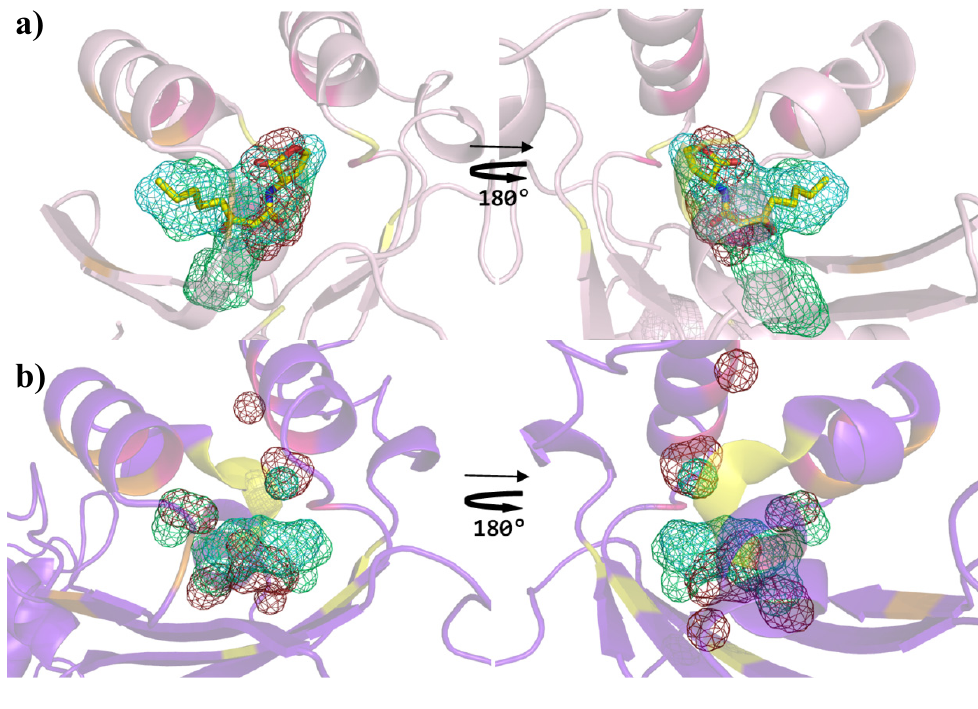
Figure 8. Comparison of the binding site preferences of prototypes of QS LuxRs and of PAB LuxR solos subfamily. Cartoon diagram ( a ) of TraR X-ray crystal structure in complex with OC8-HSL (PDB_ID 1H0M [24]) (showing the C trace of the conserved α core in yellow, of the specificity patch in magenta and of the variable patch in orange) and ( b ) of the model of OryR, showing the top ranking clusters obtained by SITEHOUND [37] as mesh: methyl carbon probe clusters (green), aromatic carbon probe clusters (cyan) and hydroxyl oxygen probe cluster (red). The carbon, nitrogen and oxygen atoms of OC8-HSL are colored in yellow, blue and red respectively. Left column: top view of the ligand binding sites (same orientation as in previous figures); right column: bottom view (obtained by 180 degree rotation around y axis). Figures produced by Pymol